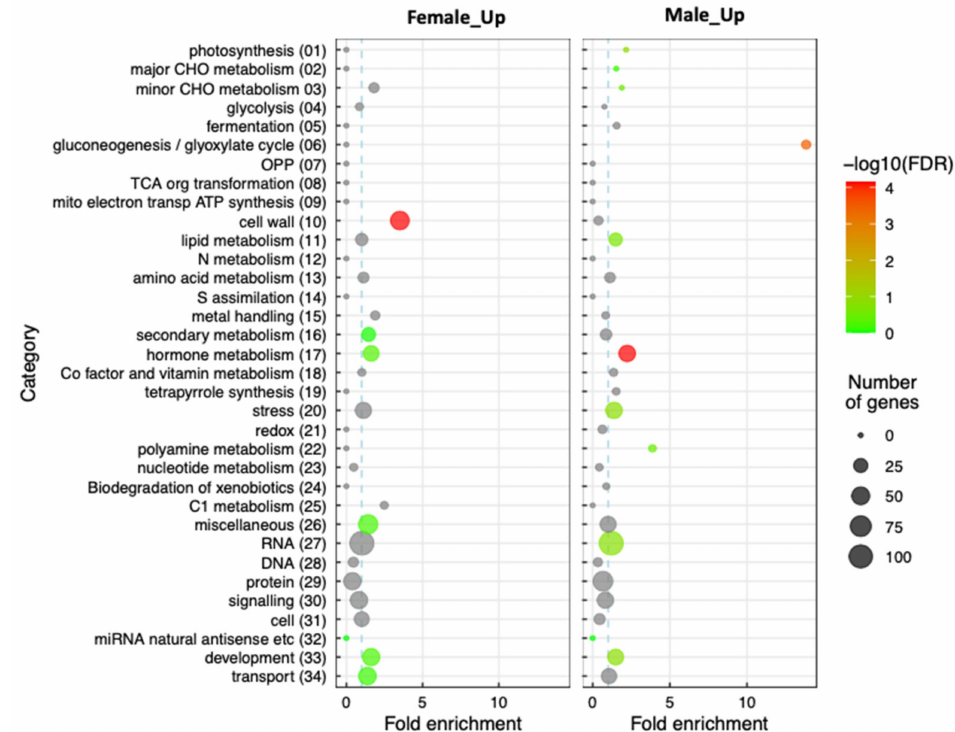
Figure 3. Enrichment of specific gene functional categories in the DEG sets as defined by Lohse et al. [30]. The color scale representing significance is based on log 10 values calculated from the FDR- corrected p values in Table S5 using the R package of Bonnot et al. [31]. Fold enrichment calculated in Table S5 is represented on the x-axis (the vertical dotted blue line denoting an enrichment ratio of 1). Circle sizes represent the number of DEGs for each respective category as indicated. Grey circles indicate DEG set/functional category combinations with nonsignificant FDR-corrected p